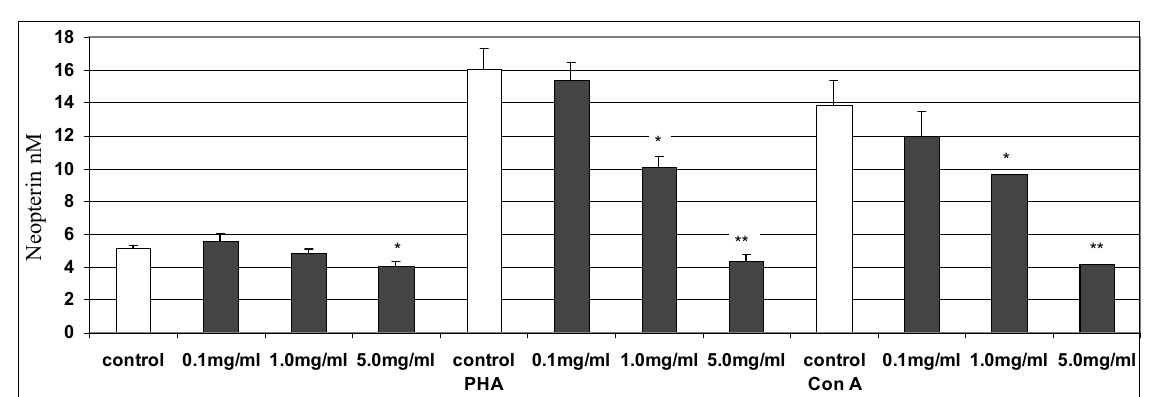
Figure 4: Concentration on neopterin in supernatants of peripheral blood mononuclear cells unstimulated (left) or stimulated with mitogens phytohaemagglutinin (PHA; middle) and concanavalin A (Con A; right) with (black bars) or without (white bars) addition of 3 different concentrations of Nigella sativa seeds extracts for 48 hours ( ∗ P < 0.05, ∗∗ P <